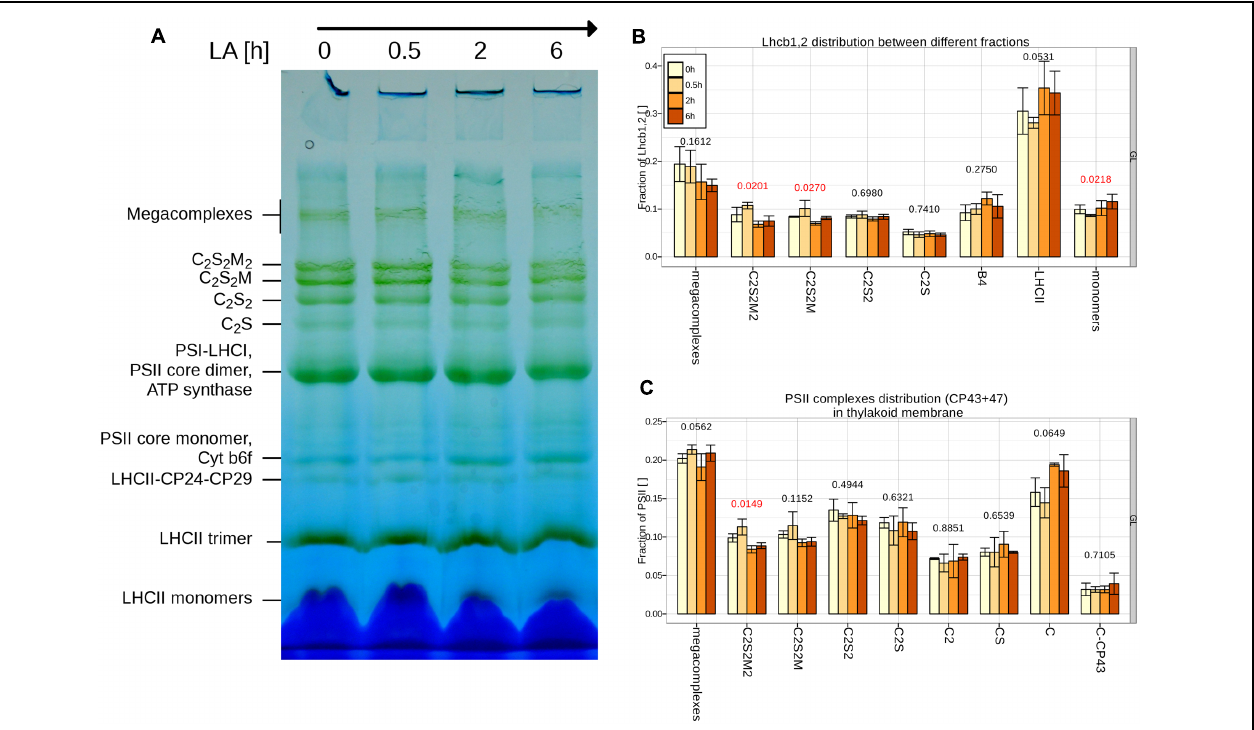
FIGURE 7 | Changes in the distribution of PSII complexes during the first 6 h of HL. (A) BN-PAGE of thylakoids from plants grown under GL200 and transferred for 0.5, 2 and 6 h. (B) The distribution of PSII between different PSII complexes according to Lhcb1,2: supercomplexes (megacomplexes, C 2 S 2 M 2 , C 2 S 2 M, C 2 S 2 , C 2 S), different complexes (CP29 + LHCII + CP24 complex, B4; Light Harvesting complex of PSII, LHCII) and monomers; or CP43 + 47 (C) : core dimers, C 2 ; core monomers, C; core monomers without CP43, C-CP43 in isolated thylakoids separated during 2D-PAGE and quantified from three different gels ( n = 3). Thylakoids were obtained from plants grown under GL200 and transferred for 0.5, 2 and 6 h to GL1800. Red color signifies rejection of the null hypothesis that the response to all growth light is the same ( α < 0.05), black its